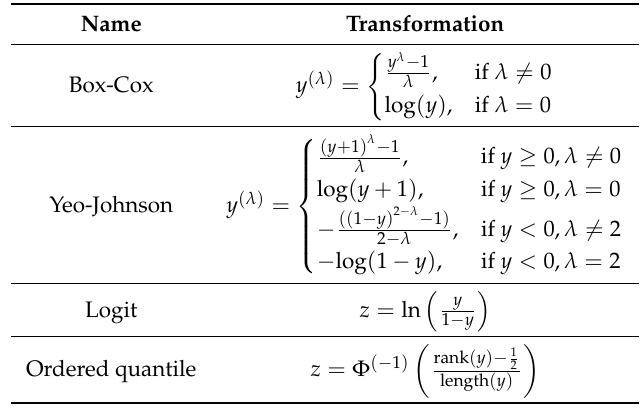
Table 1. Data normalization